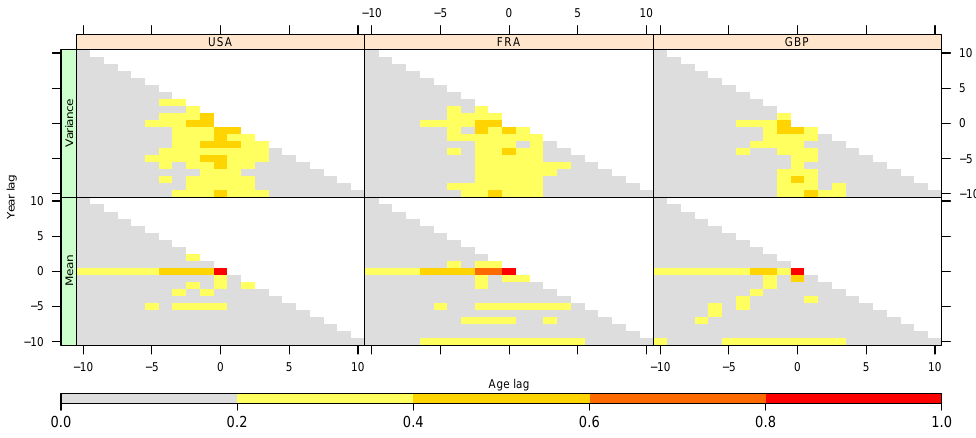
Figure 3. Autocorrelation: Autocorrelation of the random field and its squared values given in absolute value following the definition in Equation